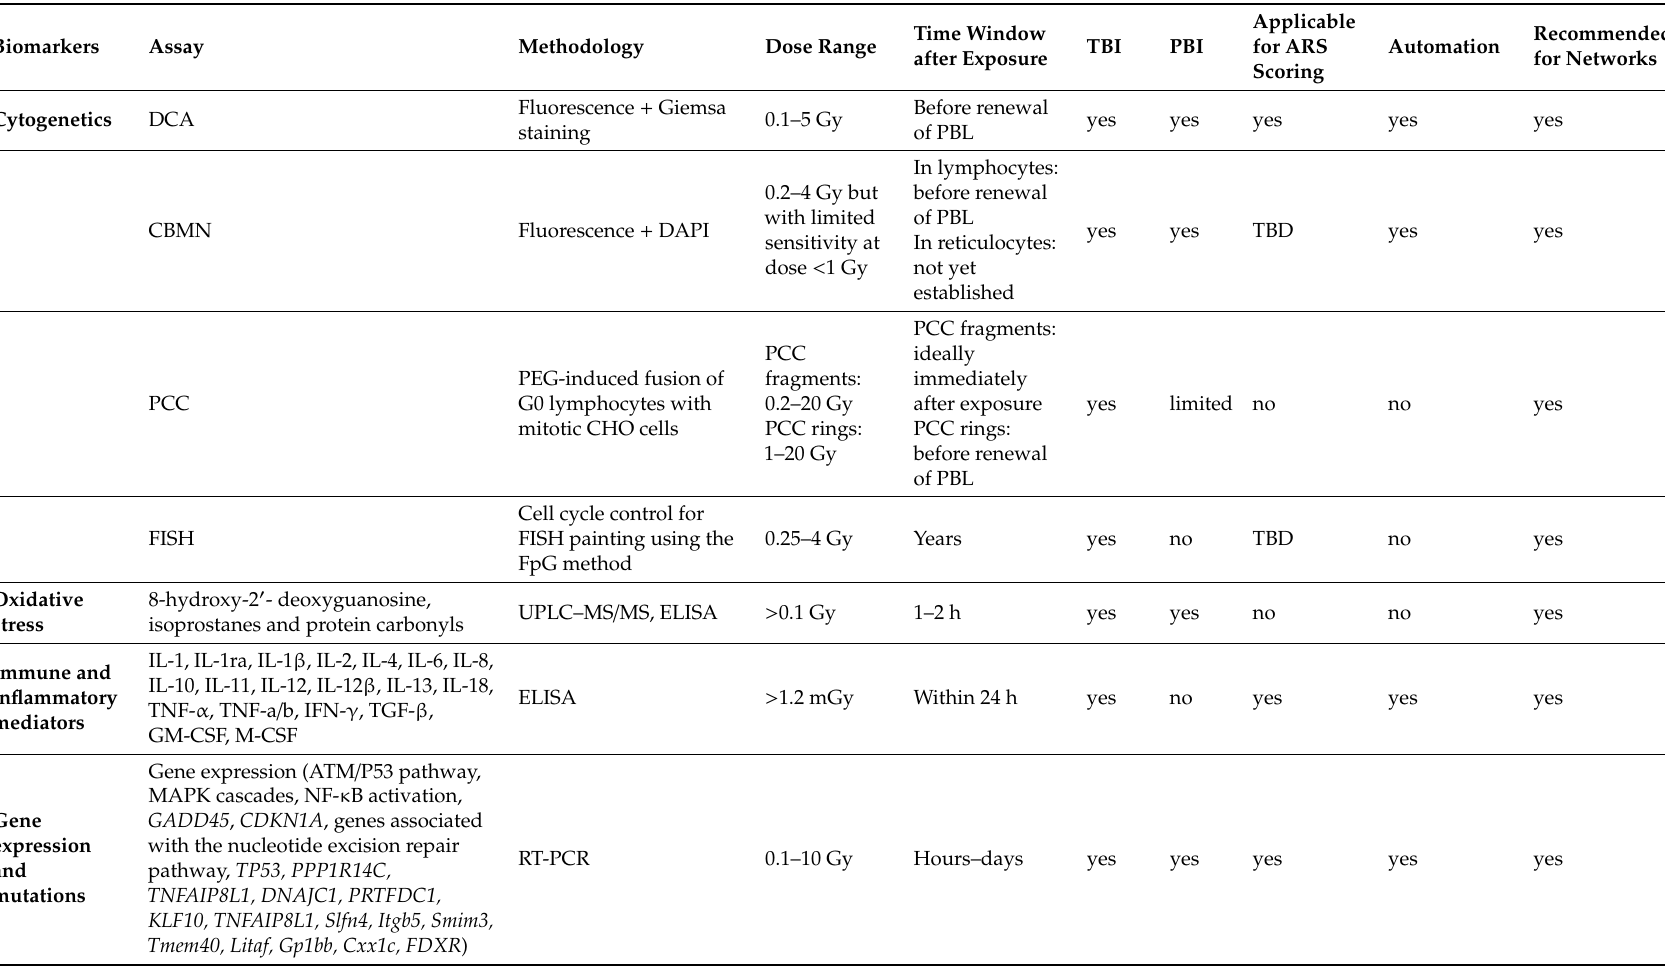
Table 2. Biomarkers of ionizing radiation-induced damage. Di ff erent assays and methodology are recommended for each type of biomarker. Dose range and timing are also indicated. TBI, total-body irradiation; PBI, partial-body irradiation; PBL, peripheral blood lymphocytes; TBD, to be determined. All other abbreviations, as well as references for each specific biomarker, can be found in Section